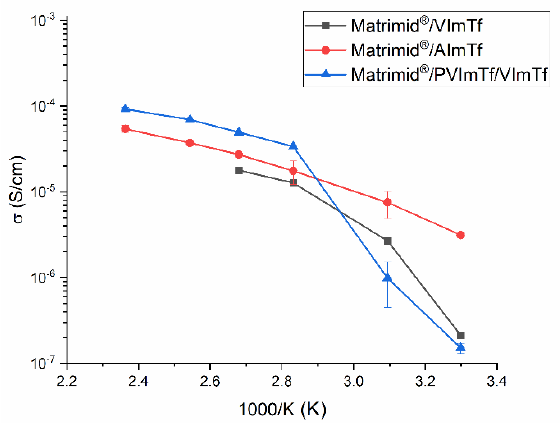
Figure 8. SILMs ’ ionic conductivity as a function of the reciprocal